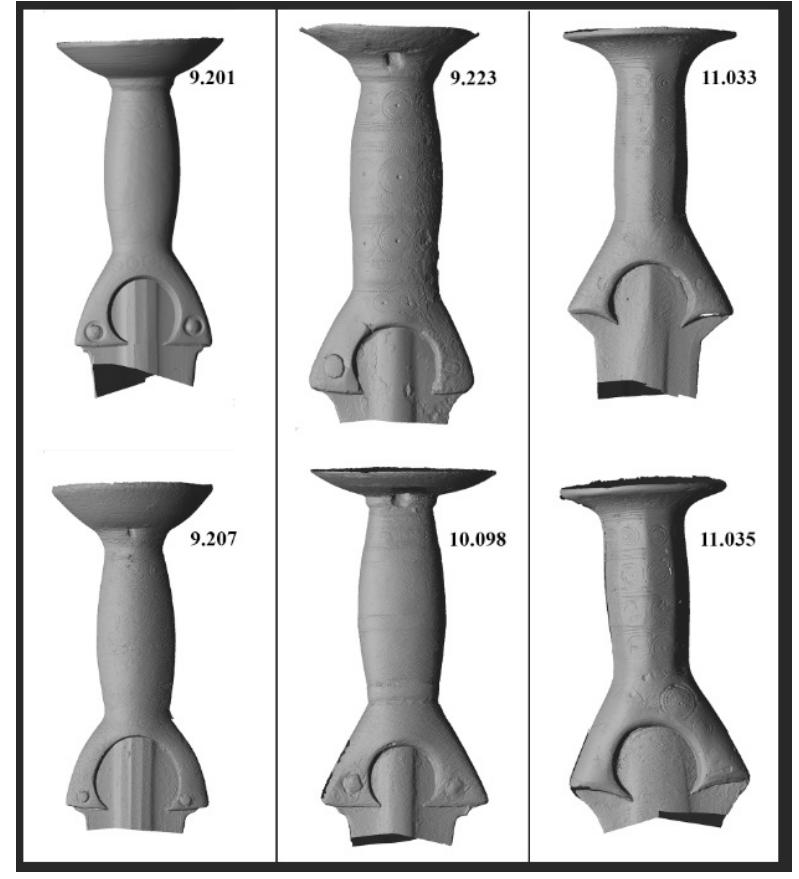
Figure 12. Swords which contain five shared manufacture based clusters. Each vertical box contains one pair with shared